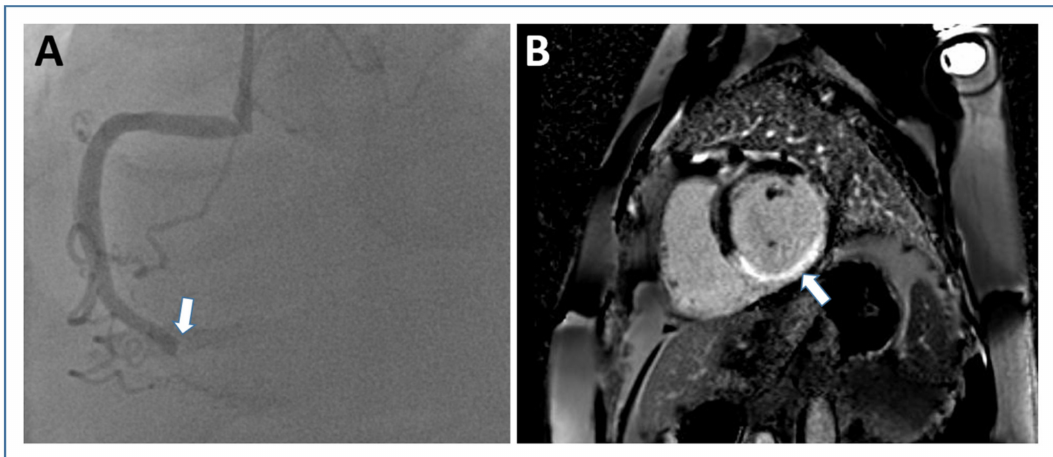
Figure 2. Infarct size assessment by late gadolinium-enhanced imaging. Short axis PSIR late gadolinium enhancement image (( B ) white arrow shows “hyper-enhanced” infarct area) from a patient with transmural inferior wall infarction due to occlusion of the right coronary artery (white arrow in ( A ) angiography). Abbreviations: PSIR, phase sensitive inversion